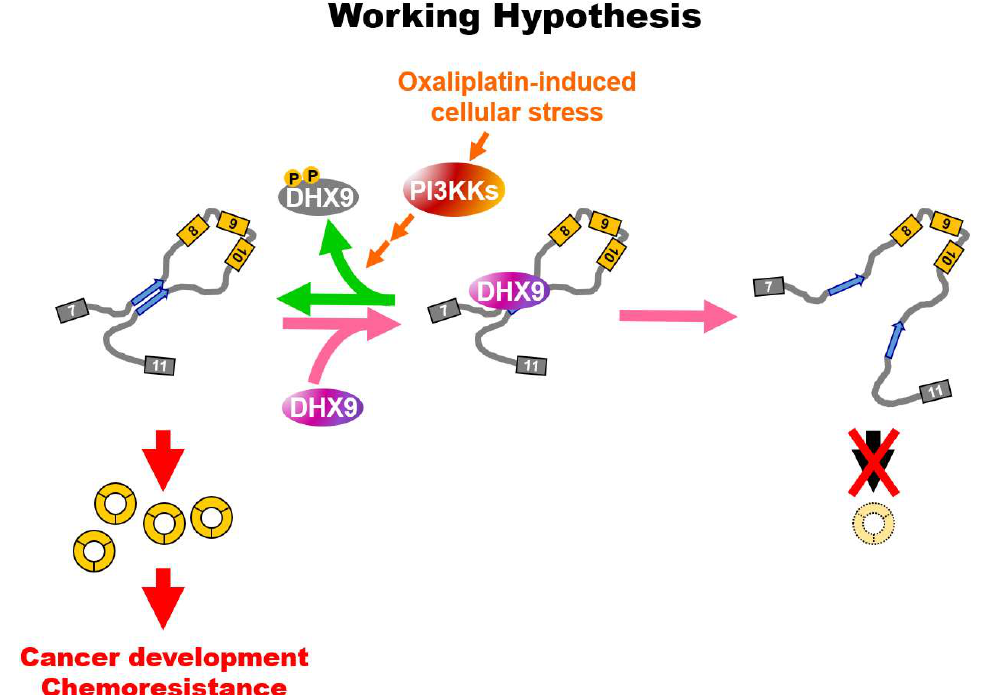
Figure 5. Phosphorylated DHX9 favors circRNA expression. The illustration of distinct populations of DHX9. Genotoxic stress-induced phosphorylated DHX9 may have a lower capacity to access RNA substrates, favor the interaction between intronic sequences and, thus, allow the occurrence of backsplicing to produce circRNAs.